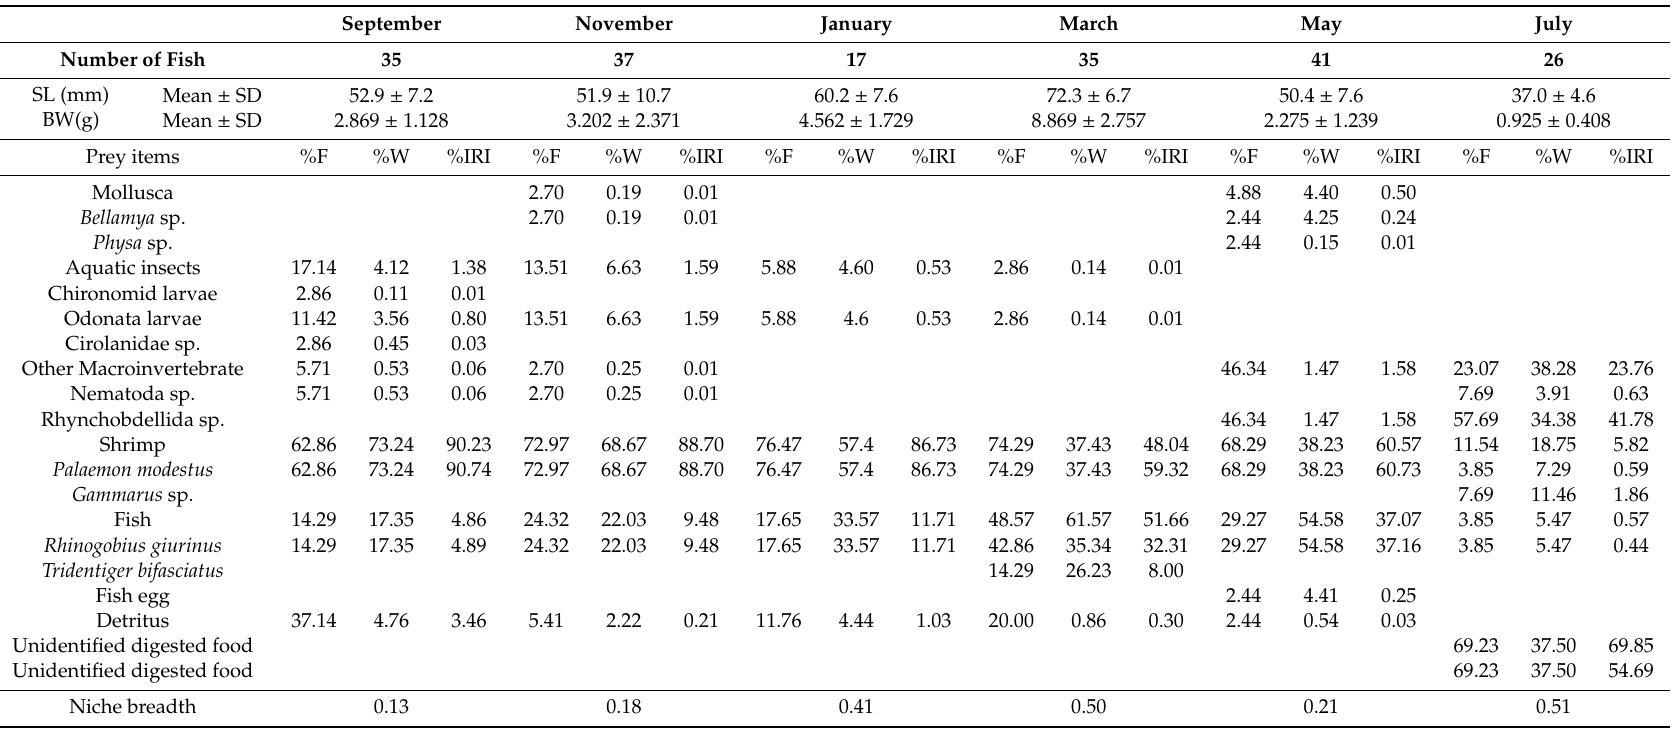
Table 1. Mean (SD) and range of standard length (SL) and body weight (BW), and importance of prey item categories measured by frequency of occurrence (%F), percentage of biomass (%W), and percent index of relative importance (%IRI) for invasive Shimofuru goby ( Tridentiger bifasciatus ) collected in di ff erent months in the Nansi Lake, China.